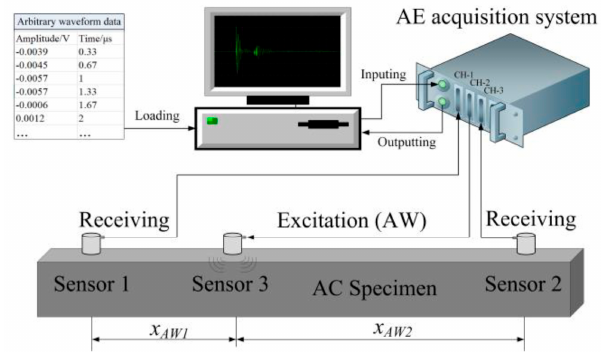
Figure 6. Measurement of the wave velocity by the AW method.